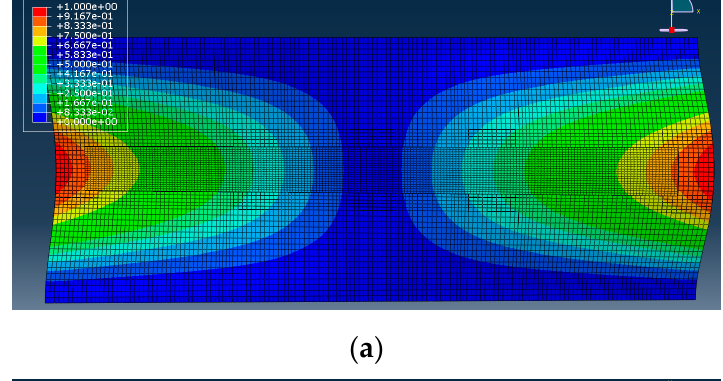
Figure 14. Mode 27 ( a ) and mode 35 ( b ).